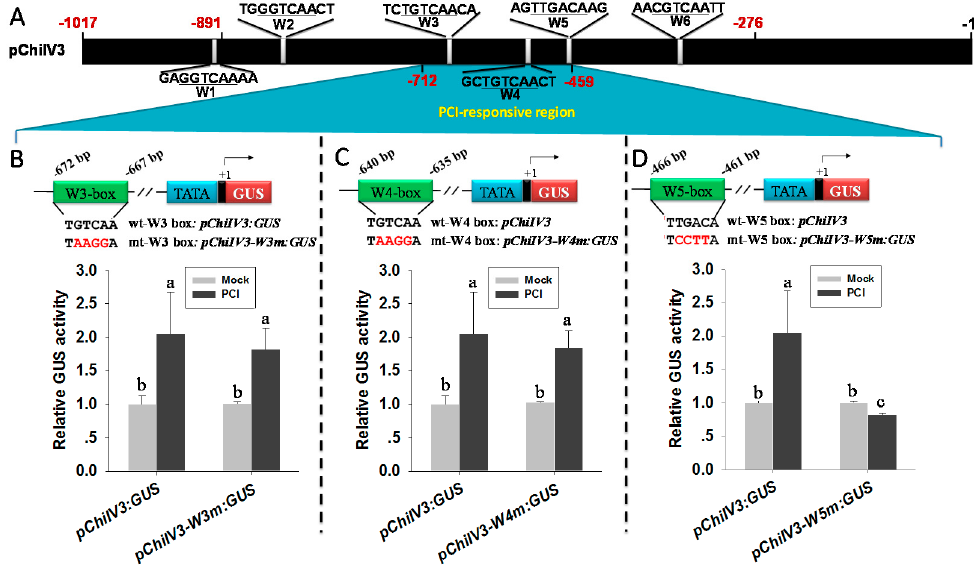
Figure 7. Site-directed mutagenesis analysis of ChiIV3 promoter in response to P. capsici inoculation. ( A ) The W-box locations in ChiIV3 promoter. The positions of the deletions are indicated by red numbers, and each W-box is indicated by a white box. The underlined nucleotides represent the core sequence of W-box; ( B – D ) The schematic diagram of pChiIV3:GUS and its W-box-mutant constructs ( pChiIV3-W3m:GUS , pChiIV3-W4m:GUS , or pChiIV3-W5m:GUS , the mutated nucleotides of W-box are in red color ) and the activities of GUS driven by pChiIV3:GUS and its three W-box-mutant in response to P. capsici inoculation in pepper leaves tissues transiently transformed with pChiIV3:GUS or its W-box-mutant constructs, respectively. The GV3101 cells containing the pChiIV3:GUS or its W-box-mutant constructs were vacuum-infiltrated into the pepper leaves and maintained in the greenhouse for 24 h. The infiltrated plants were then treated with P. capsici spores. The P. capsici -inoculated leaf tissues were harvested for GUS activity measurements at 2 dpi. Values are means ± SD ( n = 6). Error bars indicate SD. Different letters indicate significant differences determined by Fisher’s protected LSD test ( p < 0.05).